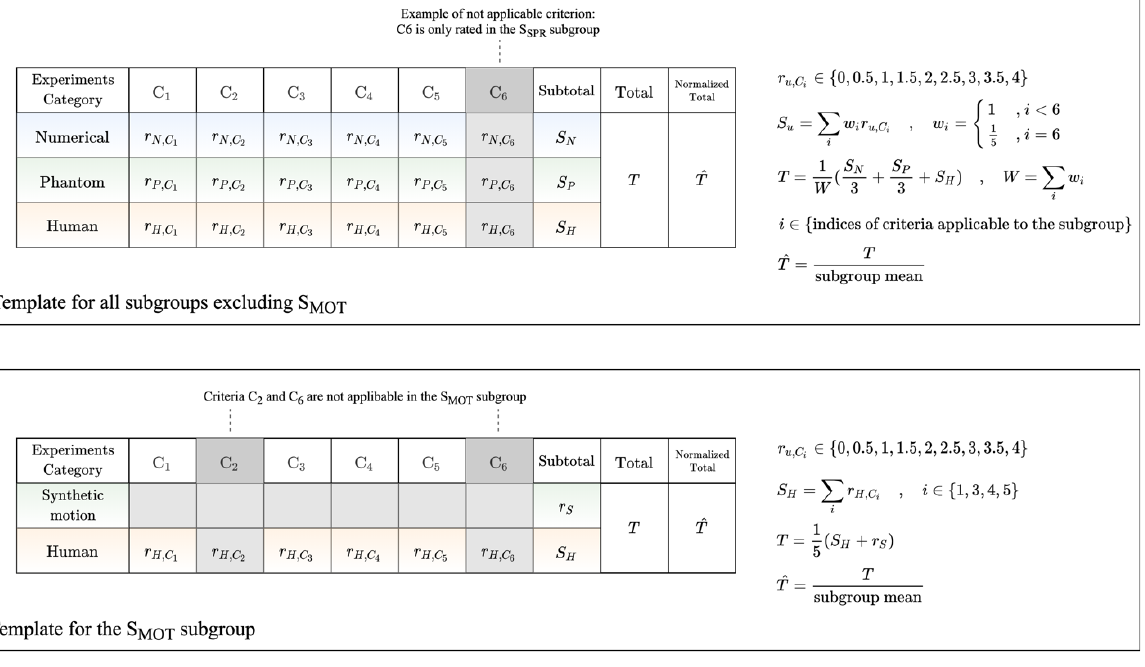
Figure 6. Illustrative overviews of the rating template and procedure for a single study. The relationships between the individual ratings, experiment category-specific subtotals, and total and normalized total ratings are described. Above , the overview for all subgroups except for S MOT . Below , the overview for the S MOT subgroup.